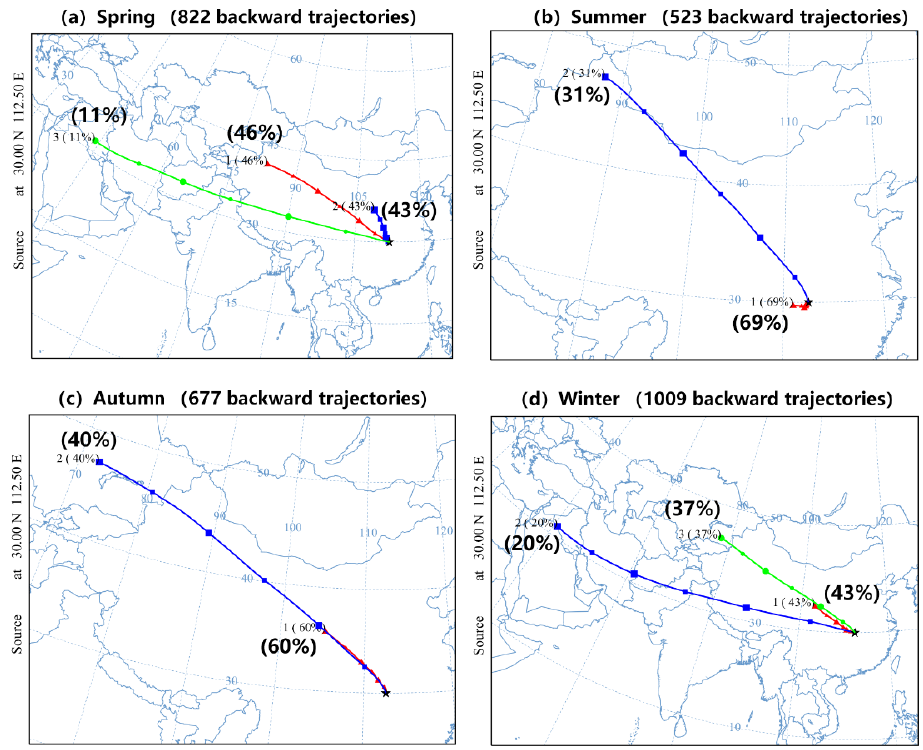
Figure 13. Clusters of dust reaching the center of the Jianghan Plain (30° N, 112.5° E) in ( a ) spring, ( b ) summer, ( c ) autumn, and ( d ) winter, from June 2006 to March 2021 as calculated by the HYSPLIT model. All backward trajectories of the dust layers observed by CALIOP were considered.